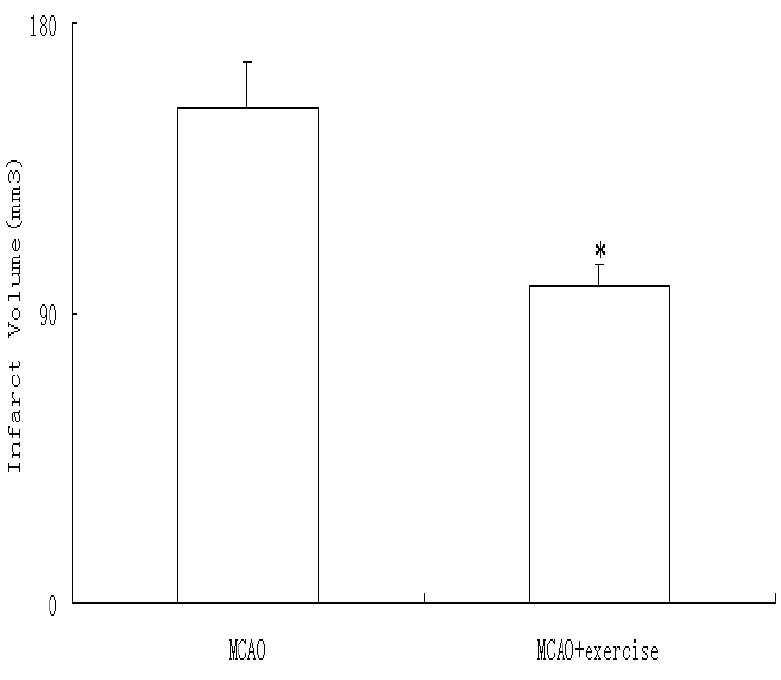
level of gluta-Group differences among the three groups were apparent at most time points, except at 0 (baseline), 200, 320 and 360 min (P < 0.05). Figure 2. Cerebral infarction volume at 48 h after reperfusion, was determined via TTC staining. MCAO animals show infarcts, which are decreased by prior exercise. Data represent mean ± SD. * P < 0.05 relative to MCAO.